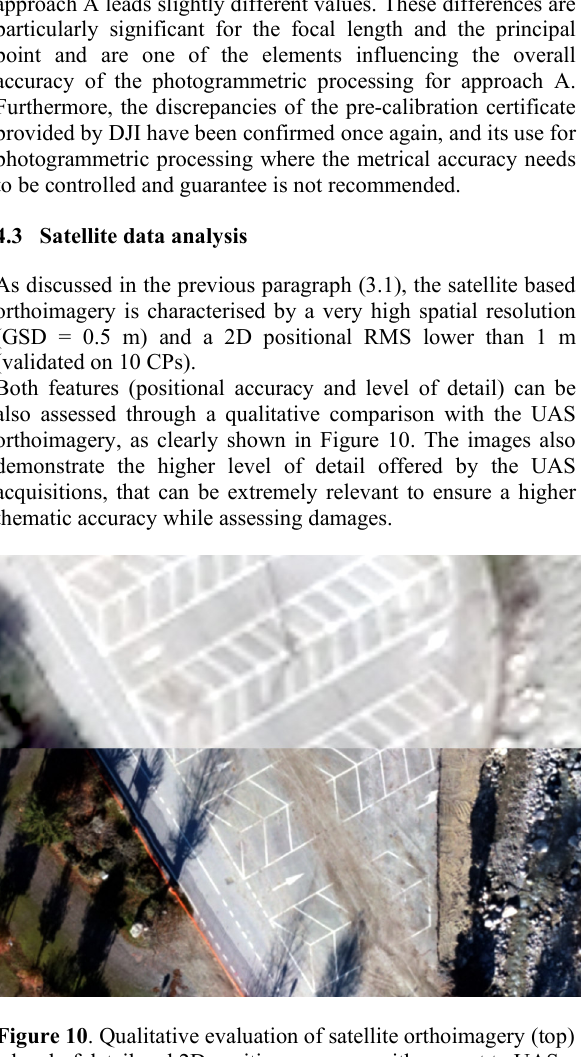
Table 6. I.O. parameters provided by DJI (Pre-calibration - PC) and estimated through a self-calibration approach in the four configurations of Strategy 2 (A, B, C, D)